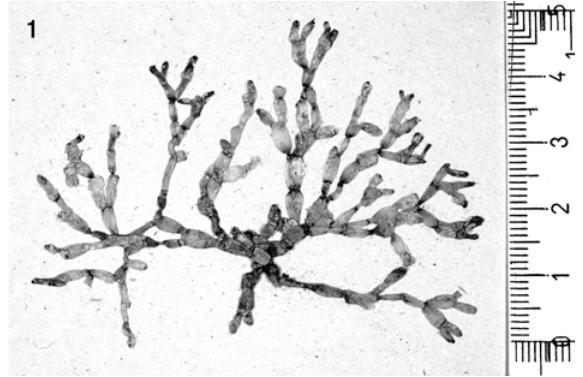
Fig. 1 – Lectotype specimen of Alysium holtingii C. Agardh. Agardh Herbarium No. 32432, Lund.